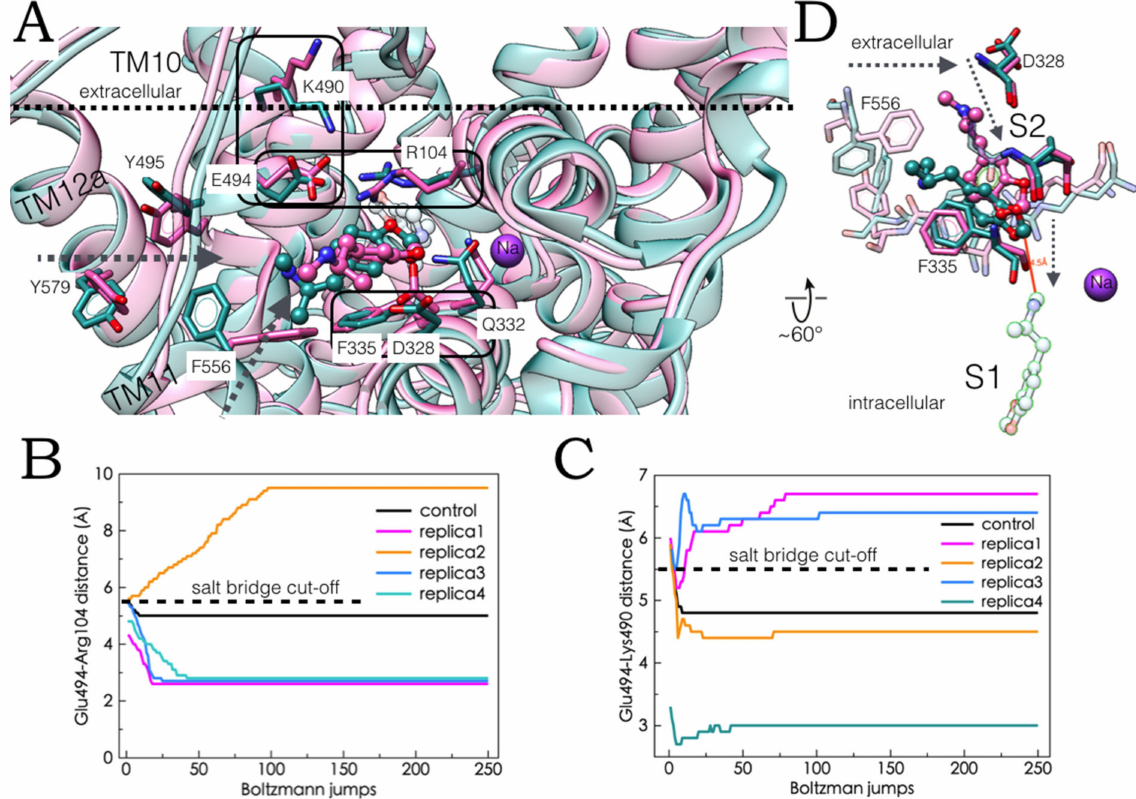
Figure 7. ( A ) MDMA/hSERT double-bound complexes subjected to Monte Carlo (MC) simulations in the ‘escitalopram-like’ orientation of the drug. Replica 3 in pink, replica 4 in blue. MDMA corresponding molecules are in ball and stick representation, MDMA at S1 is in translucent blue. The residues proposed to participate in the allosteric binding of MDMA are shown. The residues involved in the allosteric modulation of the hSERT are black rectangles. Donor-to-acceptor distance as a function of the MC energy perturbation steps for the allosterically coupled salt bridges between ( B ) Glu494 and Arg104, and ( C ) Glu494 and Lys490. ( D ) Rotated view of ( A ), in the absence of TM segments (ribbons) showing the proposed entry pathway for MDMA from S2 to